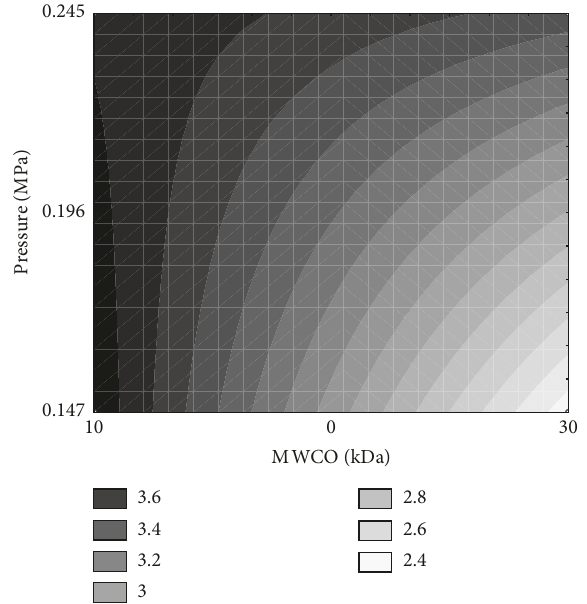
Figure 4: Contour curve for purification factor as a function of operating pressure and